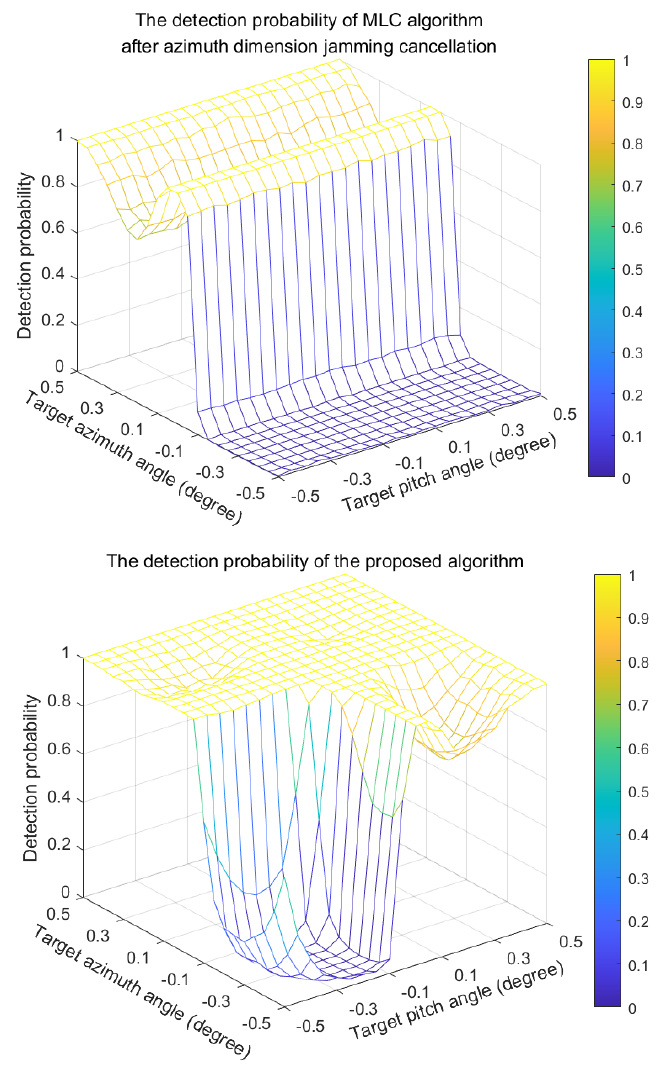
Figure 6. The detection probabilities of the two algorithms when the SJR is − 50 dB. Similarly, when the target pitch angle is − 0.2 ◦ , 0.15 ◦ , and 0.5 ◦ , the detection probability of the MLC algorithm after azimuth dimension jamming cancellation was compared with that of the proposed algorithm. When the target azimuth angle was − 0.3 ◦ , 0.05 ◦ , and 0.4 ◦ , the detection probability of the MLC algorithm after pitch dimension jamming cancellation was compared with that of the proposed algorithm. Figures 7 and 8 show the simulation results; Figure 7a–c represents the curves of the detection probability of the two algorithms with different SJR values when the target pitch angle is − 0.2 ◦ , 0.15 ◦ , and 0.5 ◦ , respectively. Figure 8a–c represents the curves of the target azimuth angle when the target azimuth angle is − 0.3 ◦ , 0.05 ◦ , and 0.4 ◦ , respectively. The curve of the detection probability with the target pitch angle was determined under different SJR values using the two algorithms.